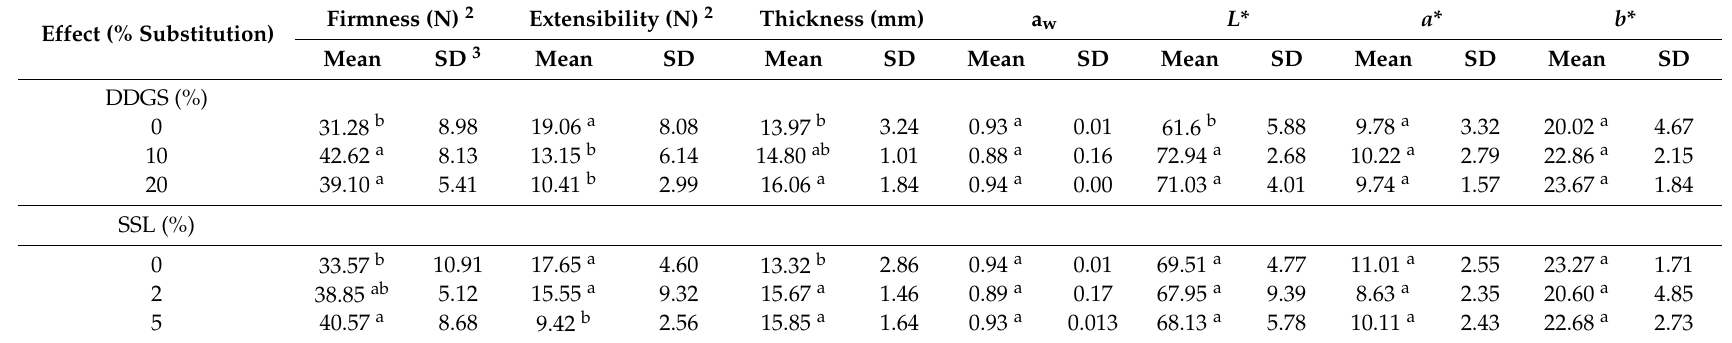
Table 4. Main effects on physical properties of baked breads 1 .